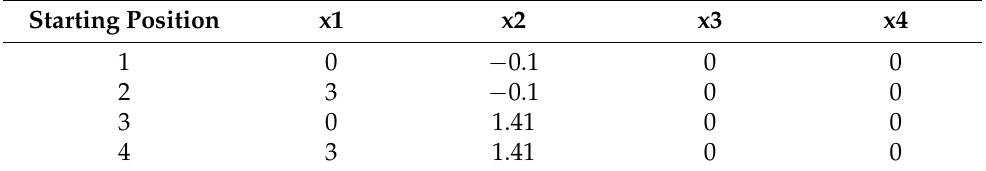
Table 10. Starting positions for fitness evaluation.